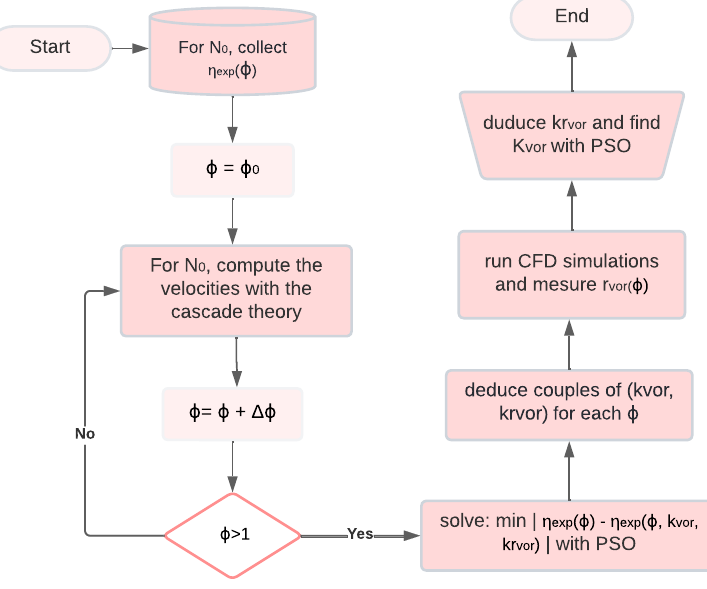
Figure 28. CFF efficiency